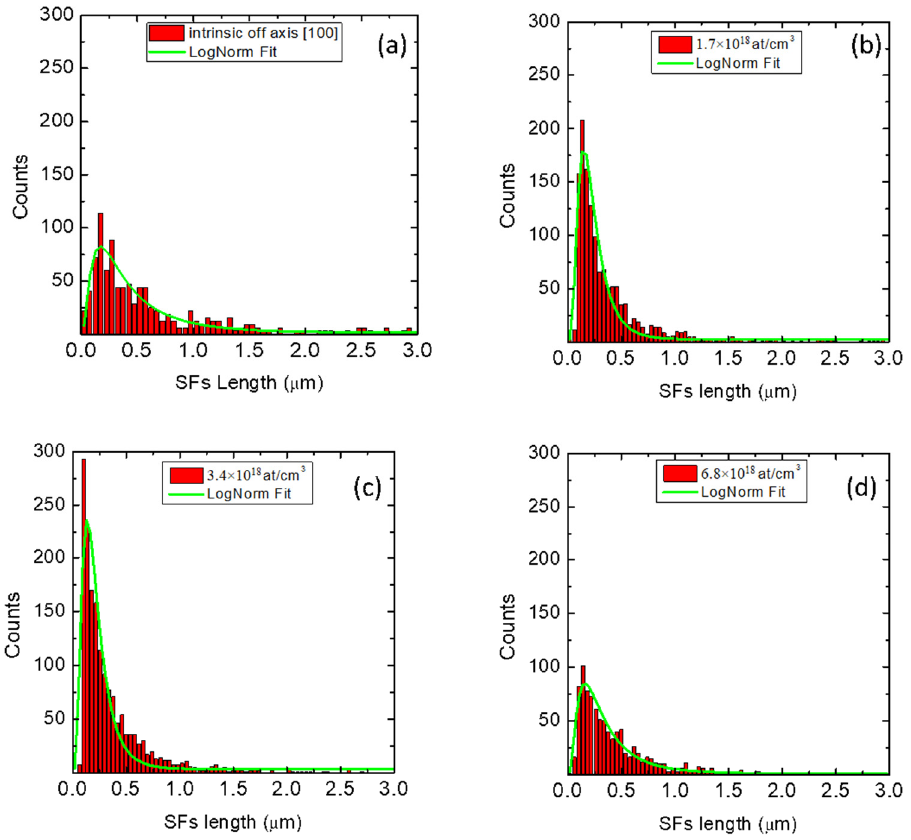
Figure 5. Length distribution of the SFs for different P-type doping. ( a ) Intrinsic sample, ( b ) 1.7 × 10 18 at/cm 3 , ( c ) 3.4 × 10 18 at/cm 3 and ( d ) 6.8 × 10 18 at/cm 3 . For all samples, there are a few SFs whose lengths are greater than the range reported in the X-axis range. However, all the lengths of the SFs were considered in the calculation of the mean lengths and densities.